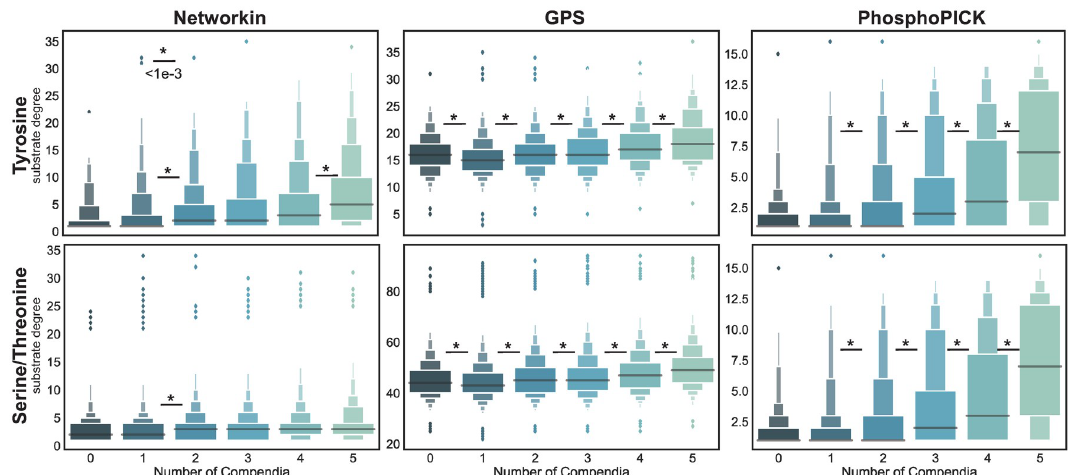
Fig 3. Effect of study bias. Each panel shows the distribution (boxen plot) of the number of high stringency kinase connections a substrate has, where substrates are grouped according to the number of compendia they were annotated in, where the more the compendia a substrate is in the more likely it was part of a training set for the algorithms (i.e. a type of study bias). Distributions are plotted for high-stringency networks for NetworKIN, GPS, and PhosphoPICK (from left to right) and for tyrosine (top) and serine/ threonine networks (bottom). To test if there is a difference between one compendia group and the next higher compendia group, we performed pairwise Kolmogorov-Smirnov (KS)-tests, where � denotes < 1e-3 p-value, indicating the data do not come from the same underlying distribution, which is the expected behavior if each sample distribution by compendia was randomly pulled from the background.